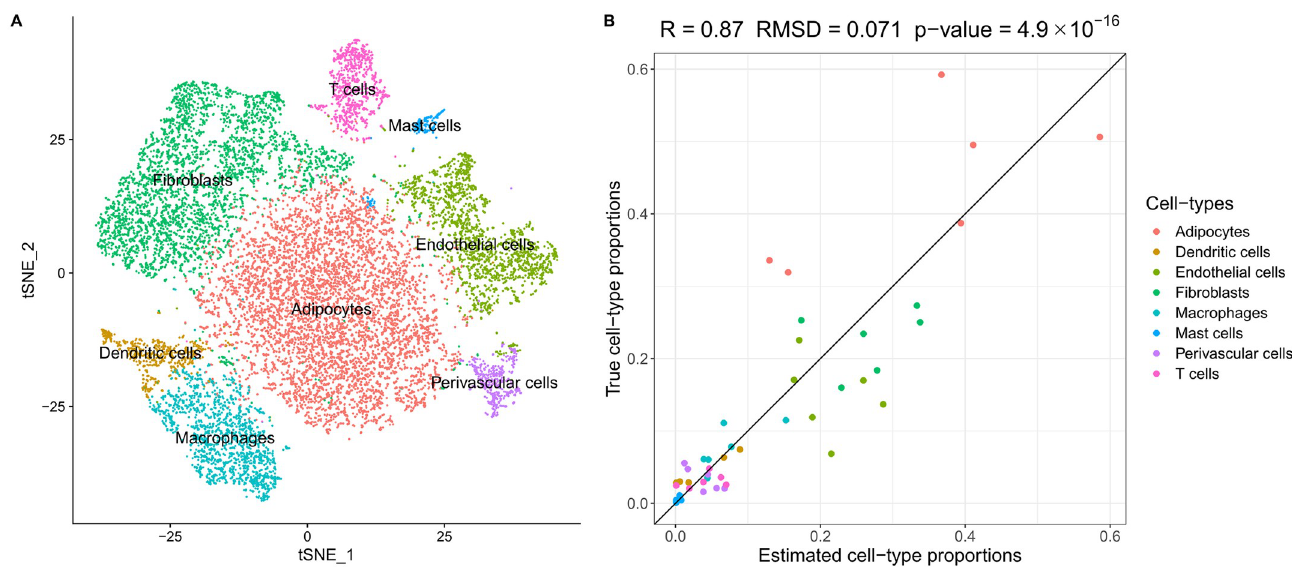
Fig 3. Analysis of sn-RNA-seq data reveals tissue heterogeneity in human subcutaneous adipose tissue. (A) We identified 8 cell-type clusters in 15,623 nuclei from frozen human adipose tissue from 6 Finnish individuals. The t-SNP plot is colored by the identified cell types. (B) Using sn-RNA-seq as reference, the estimated adipose cell-type proportions from bulk adipose RNA-seq data are well concordant with the true cell-type proportions.